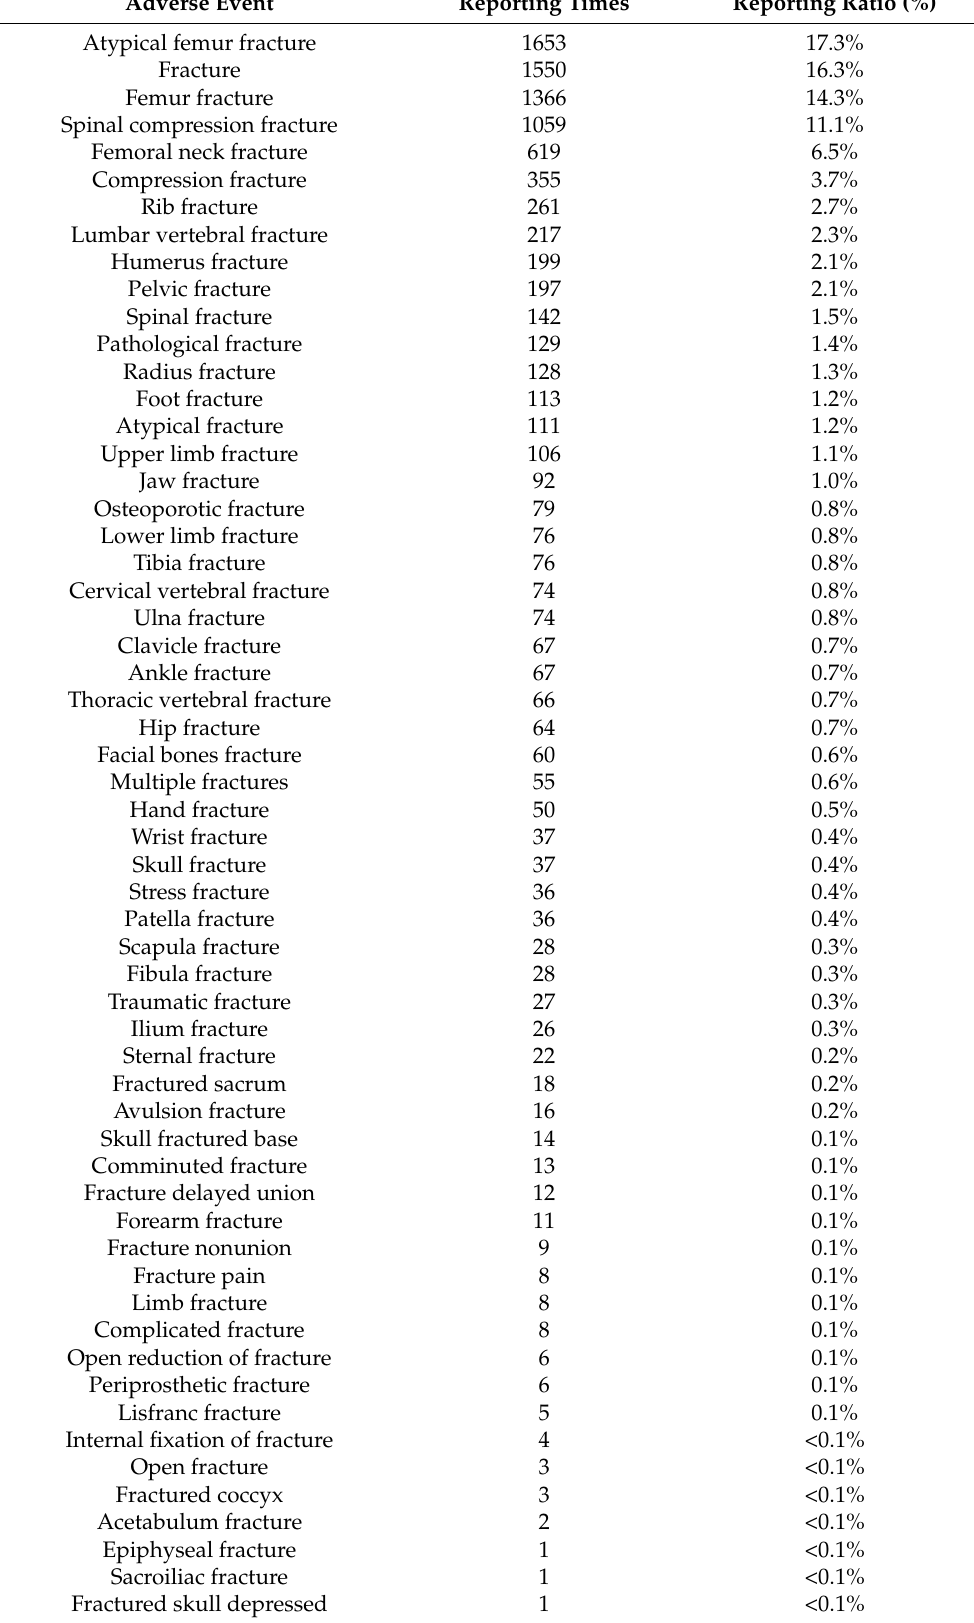
Table 1. Frequency of the 58 adverse events defined as drug-induced